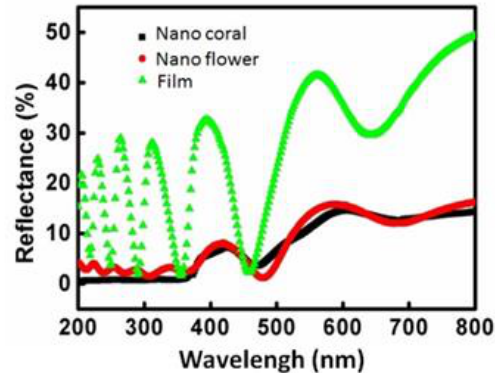
Figure 5. Specular reflectance measured on the device with film for flower-like and coral-like nanostructure surfaces.